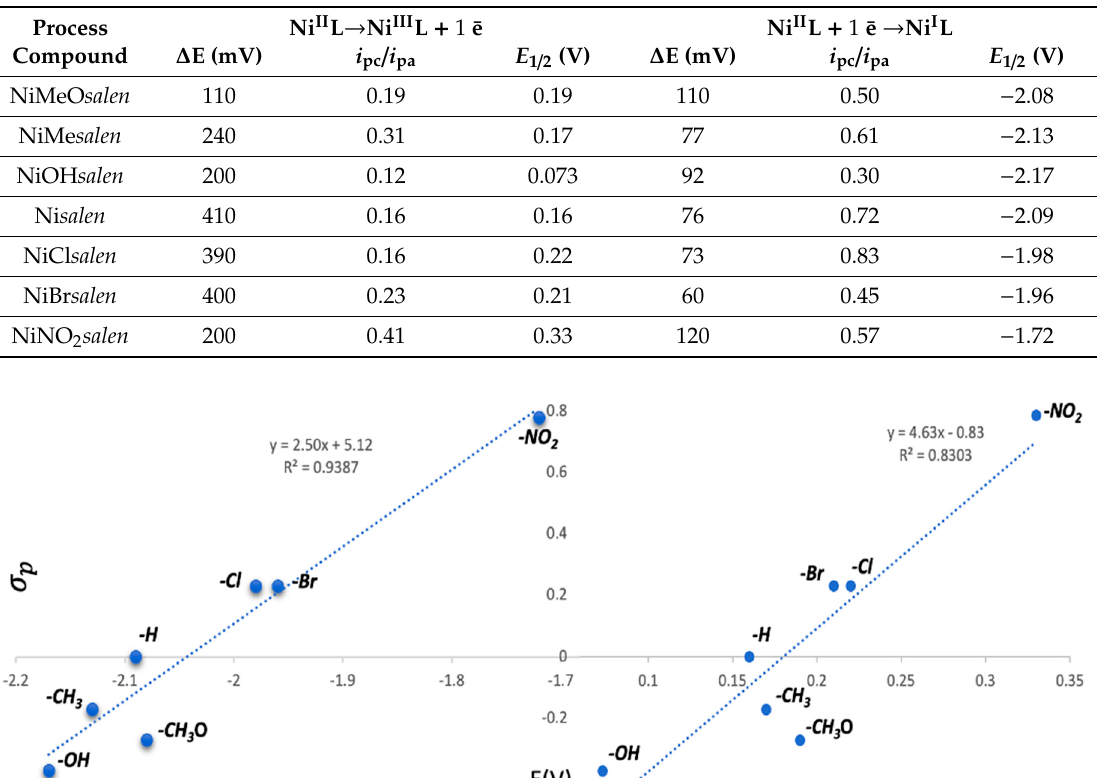
Figure 12. Voltammogram of Ni salen 1 mM (DMSO). ( a ) Ni salen voltammogram from − 3.2 to 1.0 V; ( b ) salen voltammogram from − 3.2 to 1.0 V; ( c ) Ni salen voltammogram from negative potential to 2.4 to 1.0 V; ( d ) Ni salen voltammogram from positive potential to − 2.4 to 1.0 V. All the experiments were referenced to the pair Fc + / Fc. Table 4. Cyclic voltammetric parameter for NiR salen complexes, referenced to the pair Fc + / Fc.